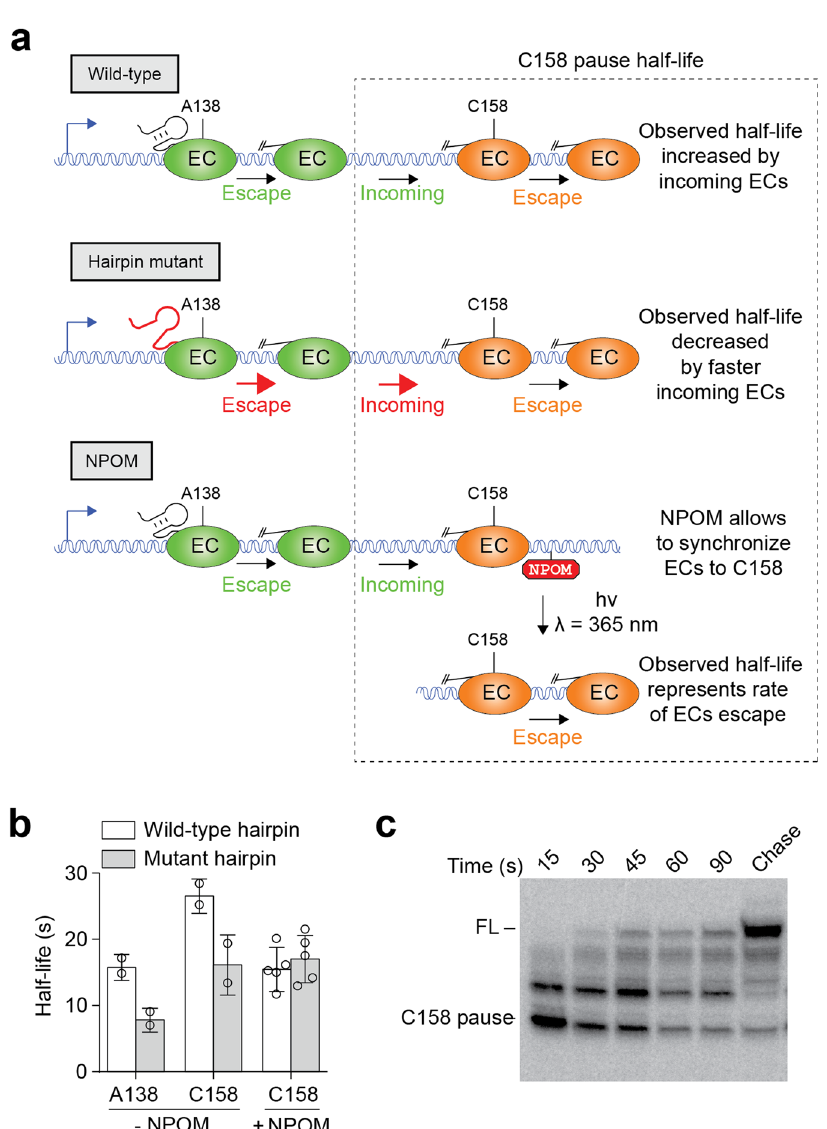
Fig. 5 Application of NPOM for the study of the C158 pause in the E. coli thiC riboswitch. a The thiC riboswitch contains two consecutive transcriptional pauses. Due to its upstream location, ECs escaping the A138 pause may arti fi cially increase the half-life of the C158 pause. In the context of a A138 hairpin mutant, ECs escape the A138 pause at a faster rate, therefore arti fi cially decreasing the C158 pause half-life. Using an NPOM-containing template to synchronize EC at the C158 pause site, the measured C158 pause half-life is expected to strictly represent the rate of pause escape, which should not be affected by the half-life of the A138 pause. b Observed half-life values of pauses A138 and C158 in the context of the wild-type and mutant hairpin constructs. Experiments were performed with and without NPOM when monitoring the C158 pause. The average values of independent experiments with standard deviations are shown. c Transcription kinetics experiment monitoring the half-life of the C158 pause in the context of the hairpin mutant. ECs were synchronized at the C158 pause site using a NPOM roadblock. NPOM removal was performed in the absence of NTPs. The experiments were performed at least two times and variations were less than